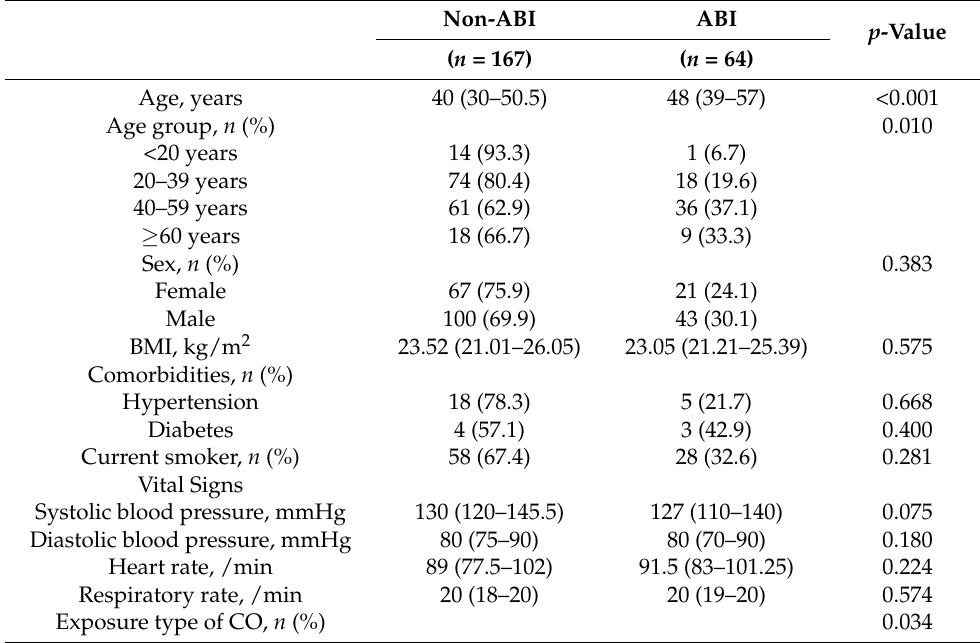
Table 2. Comparison of variables between non-ABI and ABI